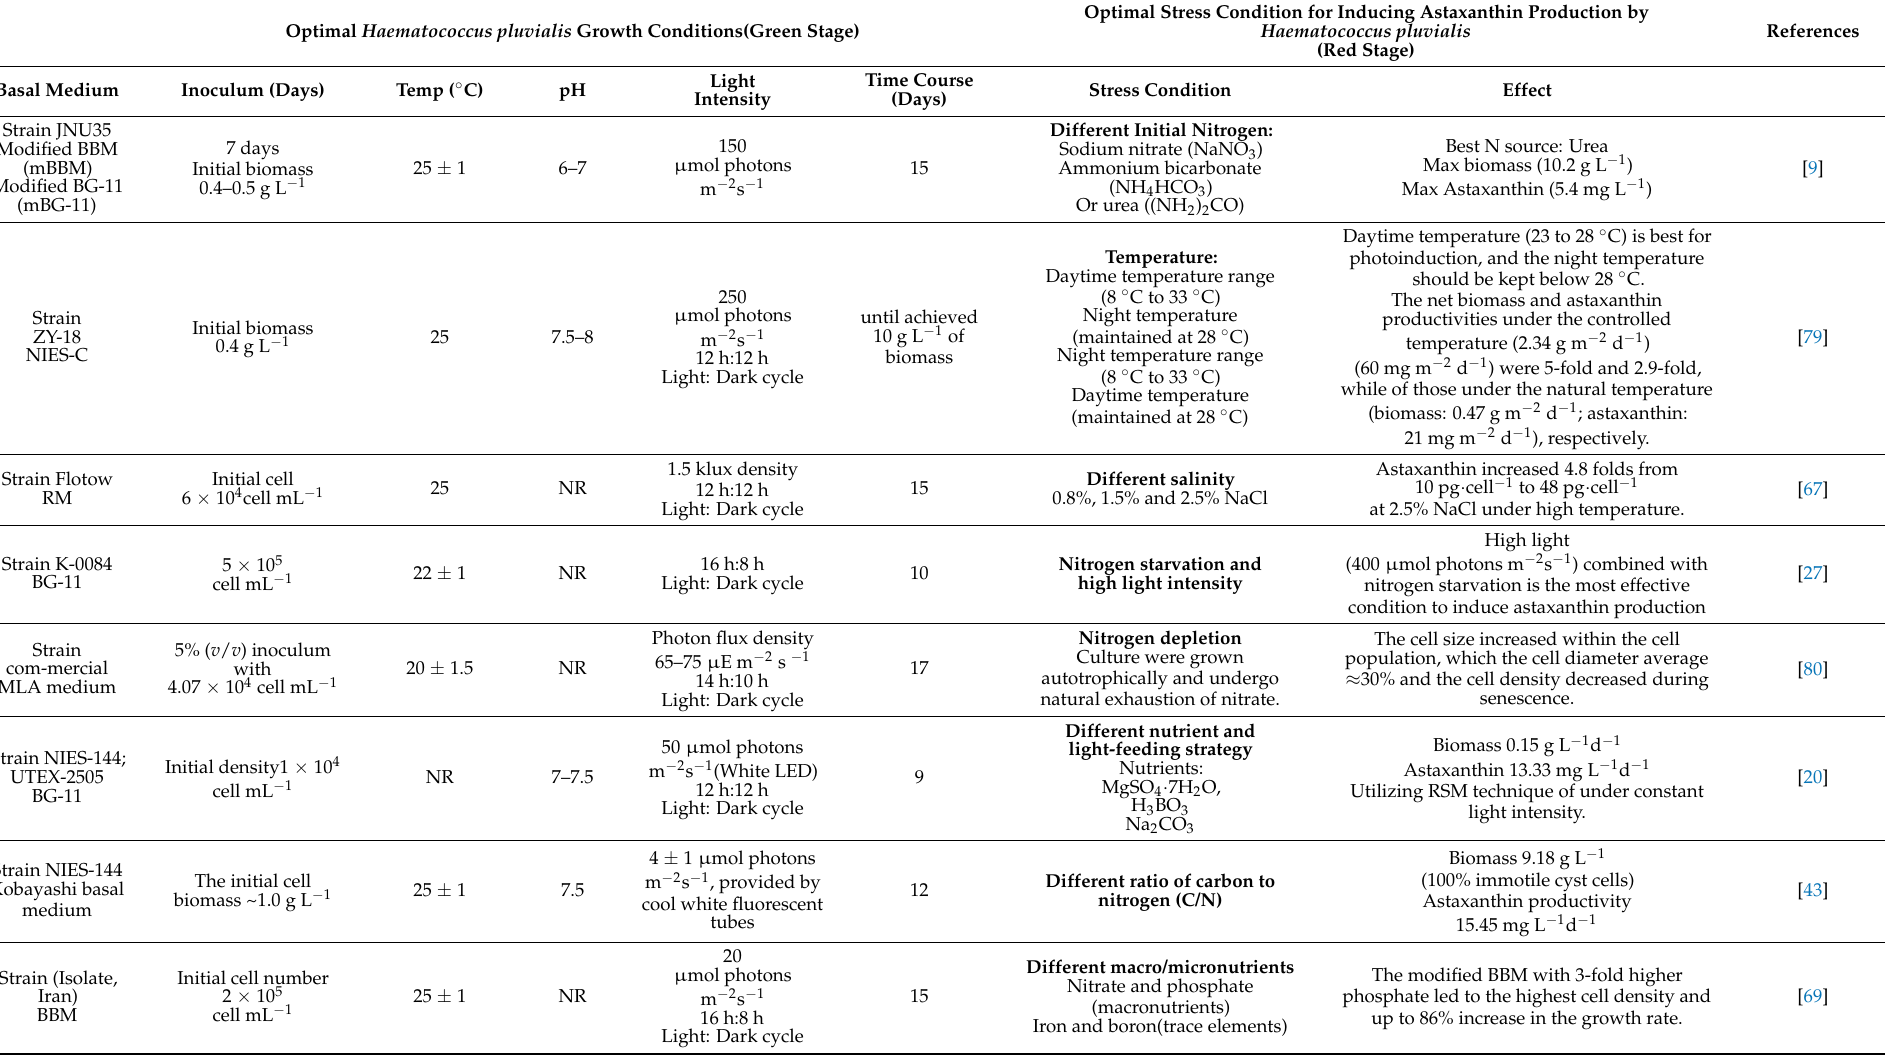
Table 1. Current strategies in inducing astaxanthin production in different strain of Haematococcus